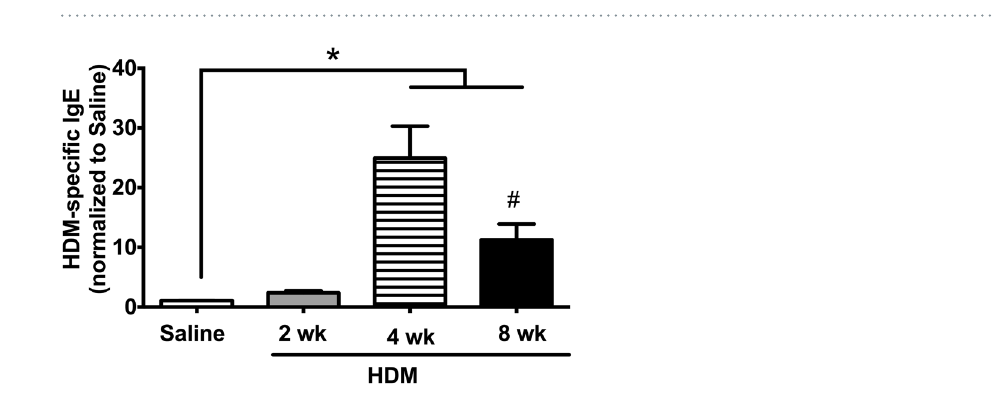
Figure 2. Enhanced methacholine responsiveness occurs in the 2, 4 and 8-Week D. pteronyssinus HDM models. Lung function assessment demonstrated that all D. pteronyssinus - exposed mice exhibited significant increases in total respiratory resistance, R rs, and central airways resistance R N to MCh relative to saline controls ( A – C , E – G , * p < 0.05, n = 7–10/group). The increases in R rs max ( D ) and R N max ( H ) were similar in all D. pteronyssinus HDM groups compared to saline controls ( * p < 0.05, n = 7–10/group).